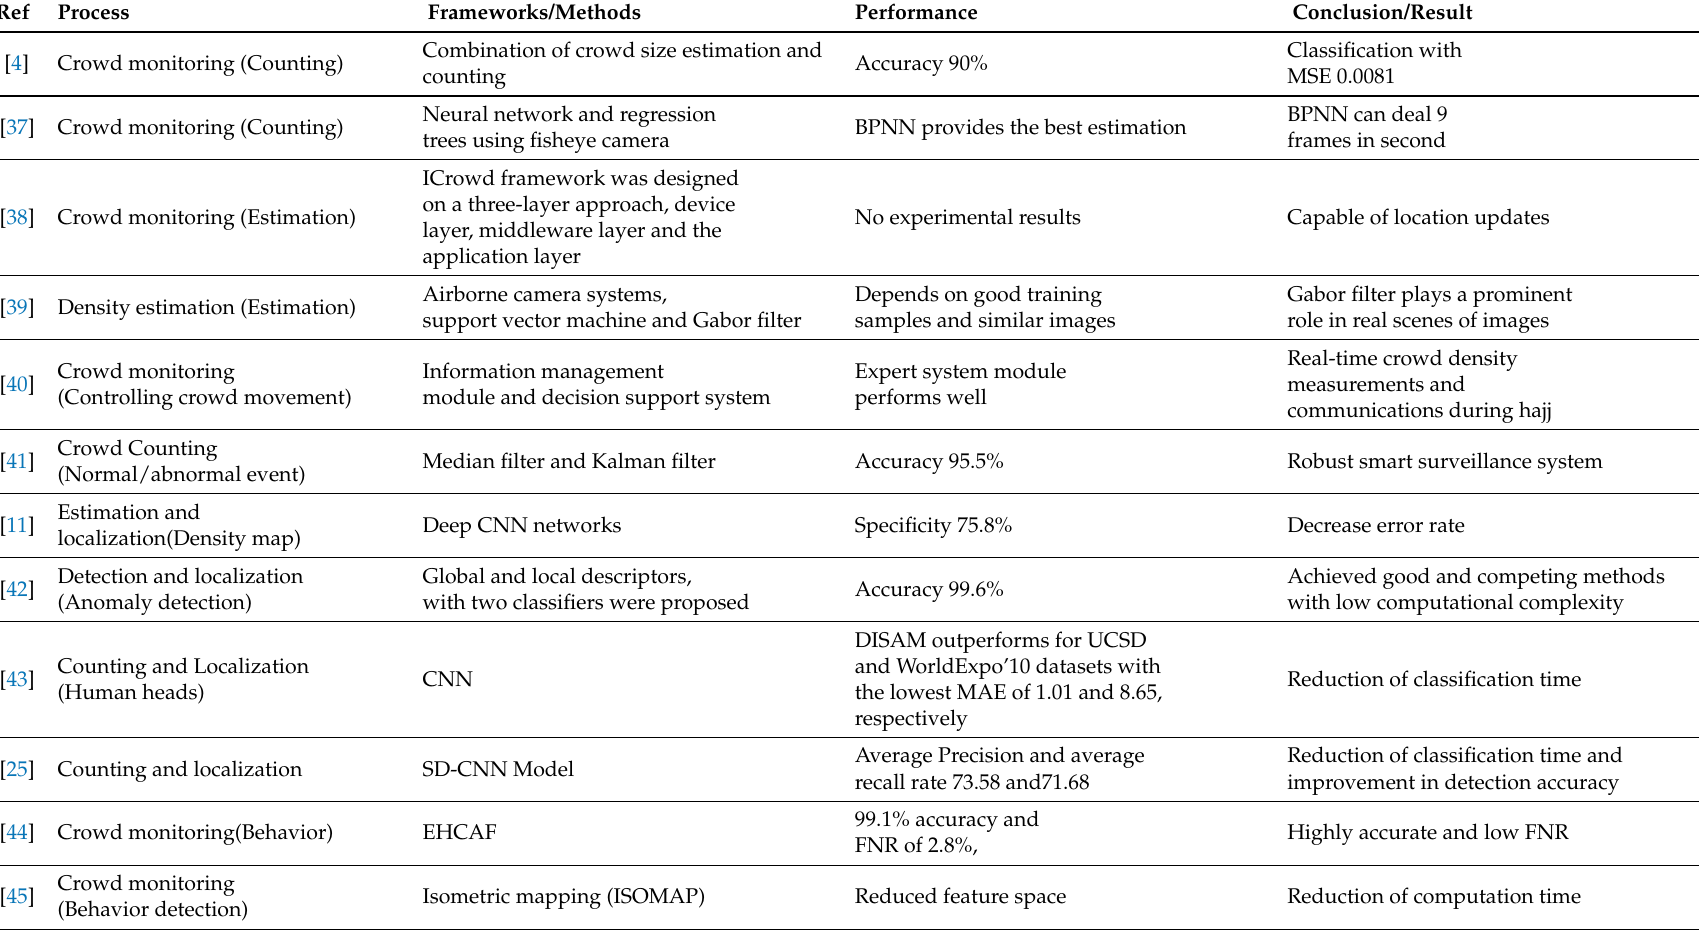
Table 2. Crowd Monitoring (CM)